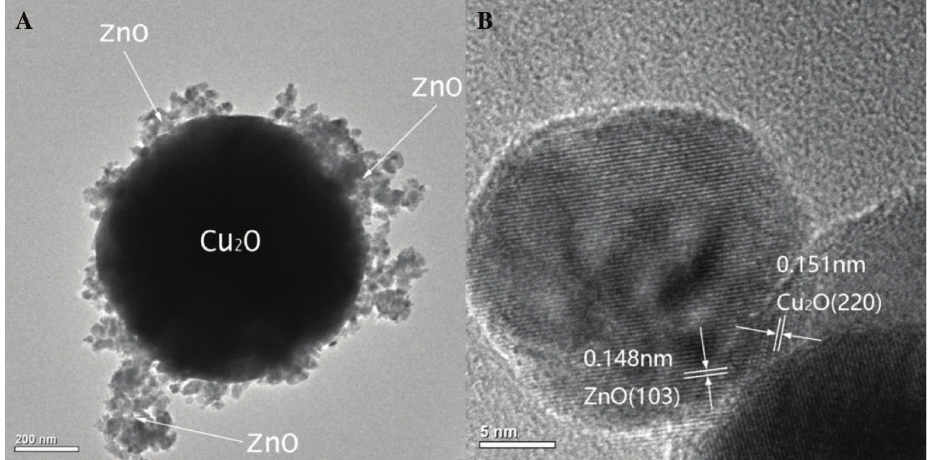
Figure 4: TEM images (A) and HR-TEM images (B) of Cu 2 O/ZnO (sample II). the visible region of λ > 420 nm. This may be due to the adsorption of ZnO on the MO. On the contrary, the num- ber of defective sites is the most important factor lead- ing to the result, such as oxygen vacancy and interstitial zinc atom, and to the acceptor states that arise from zinc vacancies and interstitial oxygen atoms [29]. The degrada- tion rate of Cu 2 O is 30% in 120 min, but it does not have extinct change after 120 min, which may ascribe to the recombination of photoinduced electrons and holes [30].